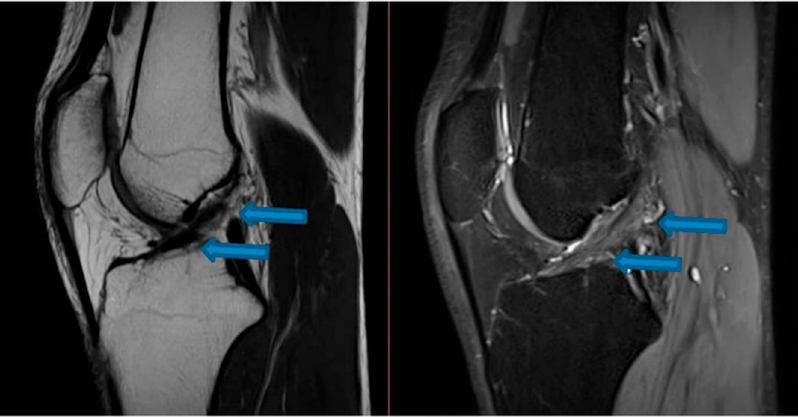
Figure 1. Sagittal T1- and T2-weighted MRI of the knee showing partial healing of the ACL indicated by blue arrows (9 November 2020).